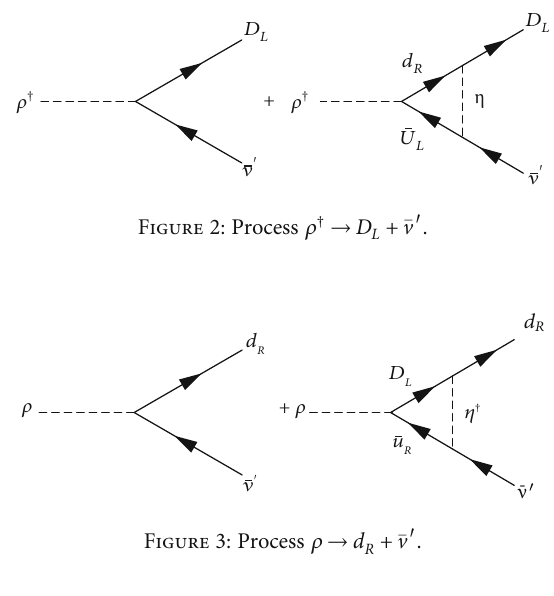
Figure 3: Process ρ → d